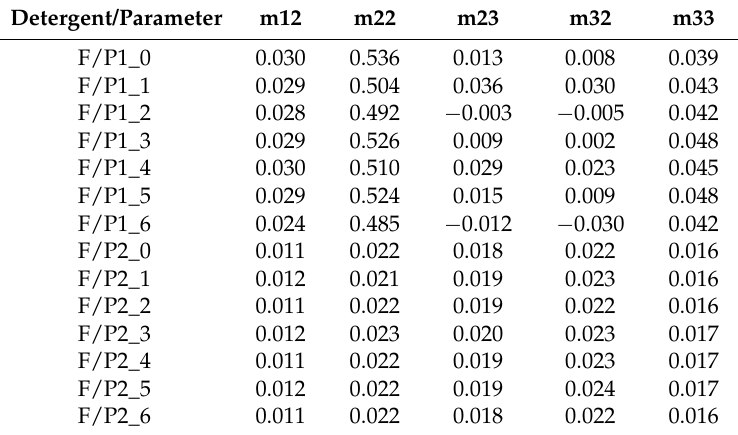
Table 1. Central moments P1 and P2 of the Mueller matrix elements for silk sample washed by fabric softener.